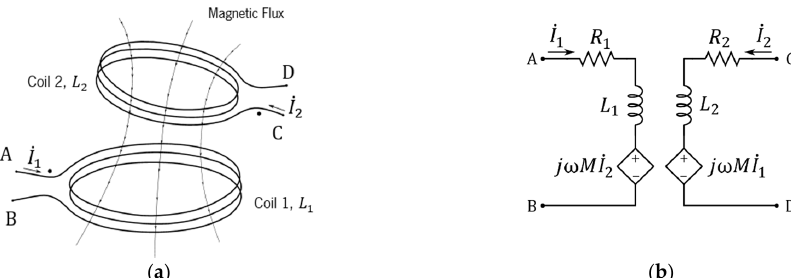
Figure 10. Magnet coupling model with negligible irradiated power: ( a ) two non-irradiating magnetically coupled coils; ( b ) simplified circuit model of the coupled coils.